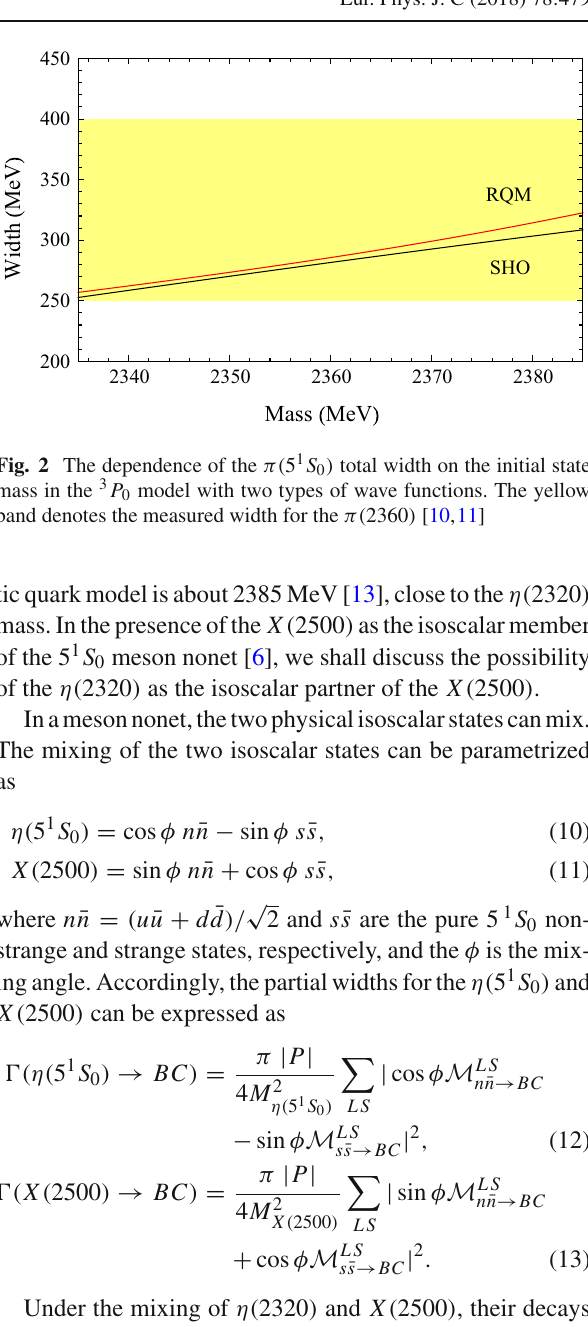
Fig. 3. In order to simultaneously reproduce the measured widths for the η( 2320 ) and X ( 2500 ) , the mixing angle φ is required to satisfy − 0 . 5 ≤ φ ≤ 0 . 45 radians in case A or − 0 . 69 ≤ φ ≤ 0 . 59 radians in case B. Below, we shall estimate the value of φ to check whether it satisfies